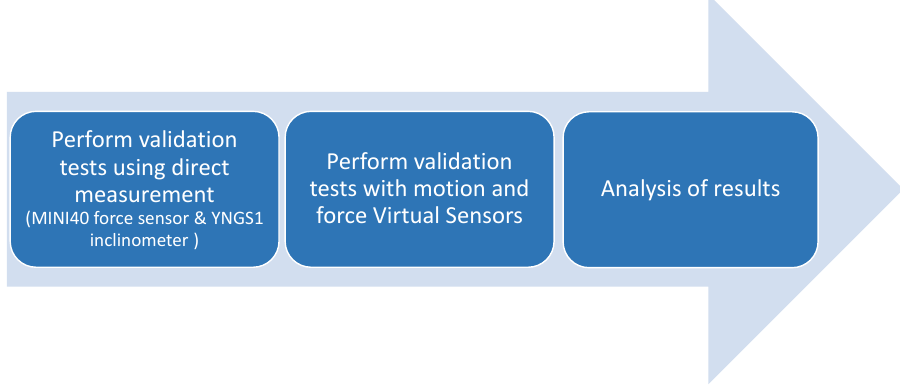
Figure 6. Procedure to evaluate the applicability and reliability of the developed Virtual